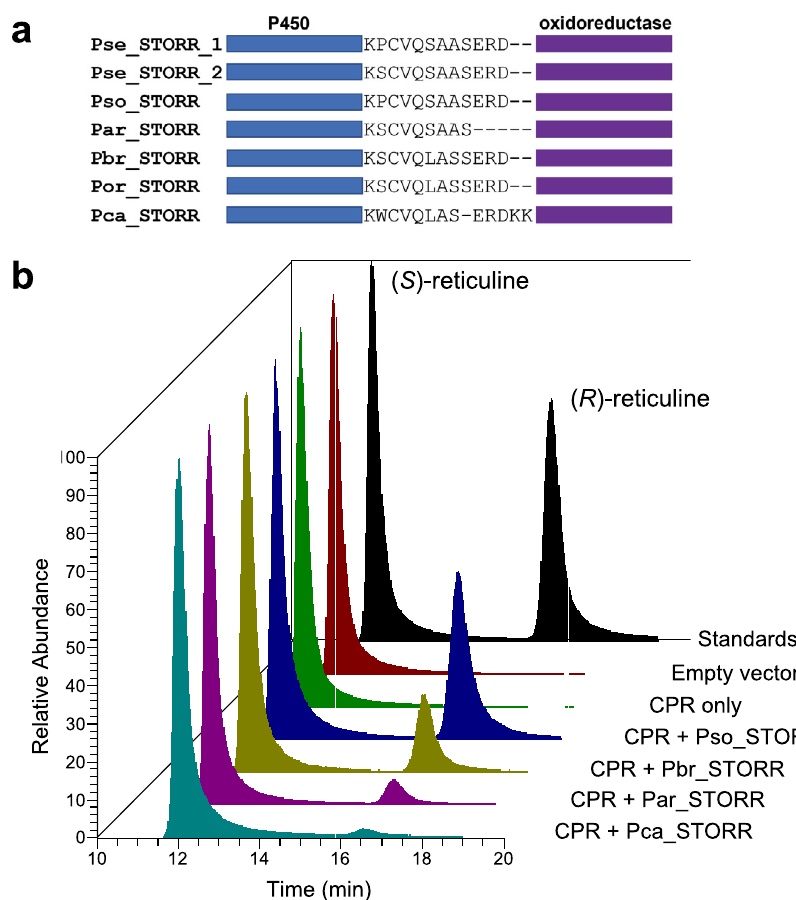
Fig. 2 Functional analysis of STORR proteins in Papaver species. a Alignment of the amino acid linker connecting the STORR P450 and oxidoreductase modules. Pse P. setigerum , Pso P. somniferum , Par P. armeniacum , Pbr P. bracteatum , Por P. orientale and Pca P. californicum . b Functional characterisation of the STORR proteins by heterologous expression in S. cerevisiae . STORR protein from P. californicum, P. armeniacum, P. bracteatum and P. somniferum were separately produced with a P. somniferum cytochrome P450 reductase (CPR) redox partner in S. cerevisiae . Microsomal proteins were assayed with ( S )- reticuline as substrate. Relative abundance is used to show the reticuline epimers present in the sample. Reticuline standards (black), pESC-trp empty vector (red), pESC-trp vector + cytochrome P450 reductase (CPR)(green), pESC-TRP + CPR + Pso STORR (blue), pESC-TRP + CPR + Pbr STORR (gold), pESC-TRP + CPR + Pam STORR (pink) and pESC-TRP + CPR + Pca STORR (cyan). Source data are provided as a Source Data fi